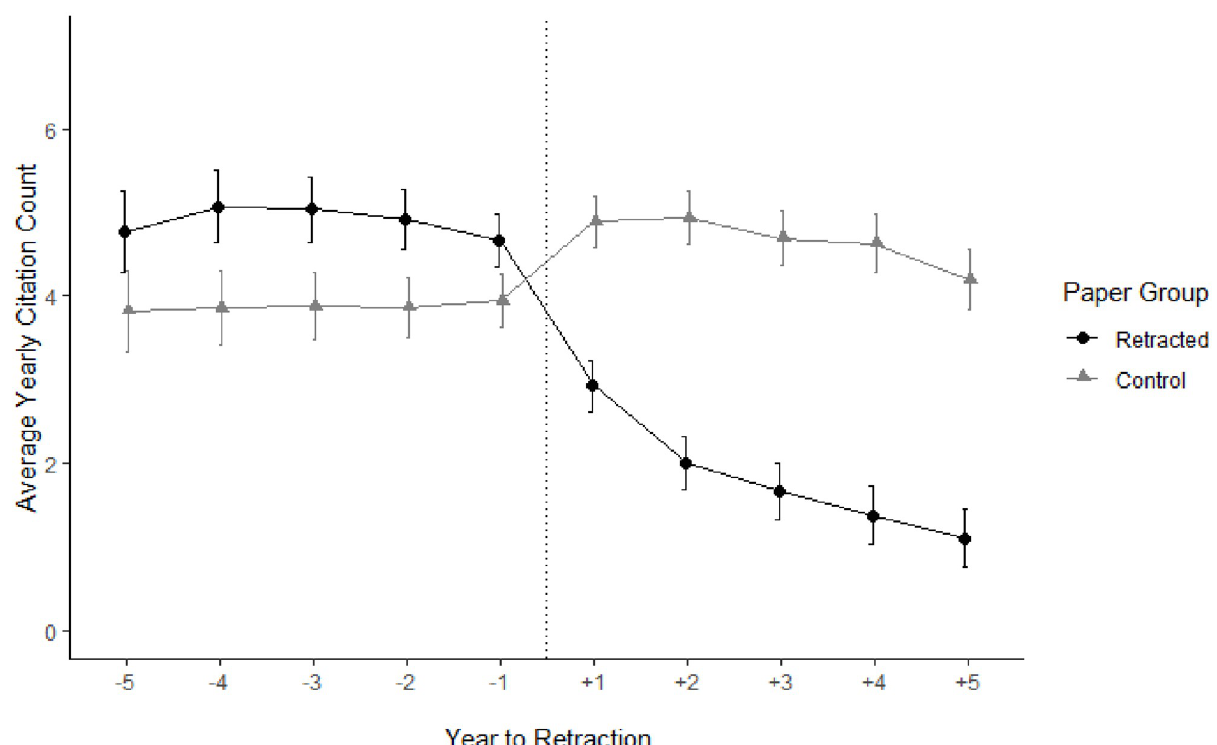
Fig 5. Retraction by time of publication, for single